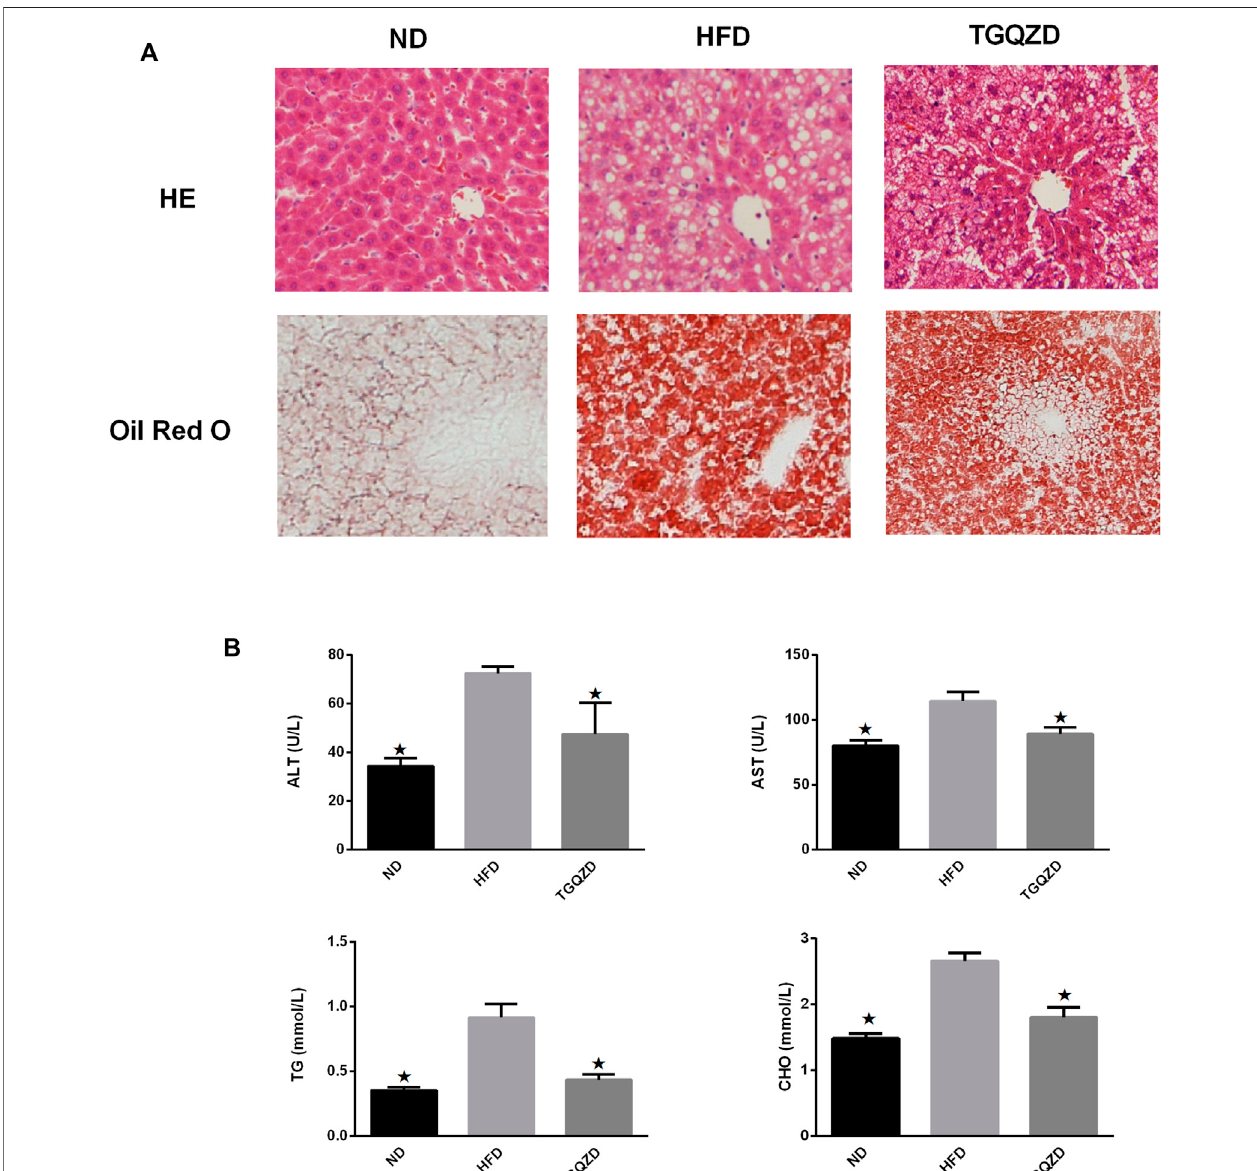
FIGURE 2 | (A) Effect of TGQZD on liver histomorphology of NAFLD rats. The HE staining showed that the morphology and structure of the liver tissue in the ND groupwerenormal;IntheHFDgroup,fattydegenerationappearedintheliver.Hepatocytesareswollenandroundandtheirvolumeissigni fi cantlyhigherthanthatofND group. There exist a large number of fat vacuoles and balloons in cytoplasm. After the treatment of TGQZD, the fatty vacuoles and balloon like changes in NAFLD rats ’ liverwereimproved.TheresultsofoilredOstainingshowedthattherewaslittleredlipiddropinthelivertissueoftheNDgroupandalargenumberofredlipiddrops in the liver tissue of the HFD group, which showed that the lipid droplets in fi ltrated into the hepatocytes and fused into pieces. Red lipid droplets were also found in liver tissue of rats in TGQZD group, but the number and the fusion into pieces were less than that in HFD group (Figure 2). Histological examination showed that fatty degeneration, in fl ammation, and hepatocyte ballooning in TGQZD group were alleviated than HFD group ( Table 3 ). (B) Effect ofTGQZD on liver function and blood lipid ofNAFLDrats.ComparedwiththeNDgroup,thelevelsofALT,AST,TGandTCintheHFDgroupweresigni fi cantlyhigher( p < 0.05);comparedwiththeHFDgroup,the levels of ALT, AST, TG and TC in the TGQZD group were signi fi cantly lower ( p < 0.05). * p < vs. HFD Group,